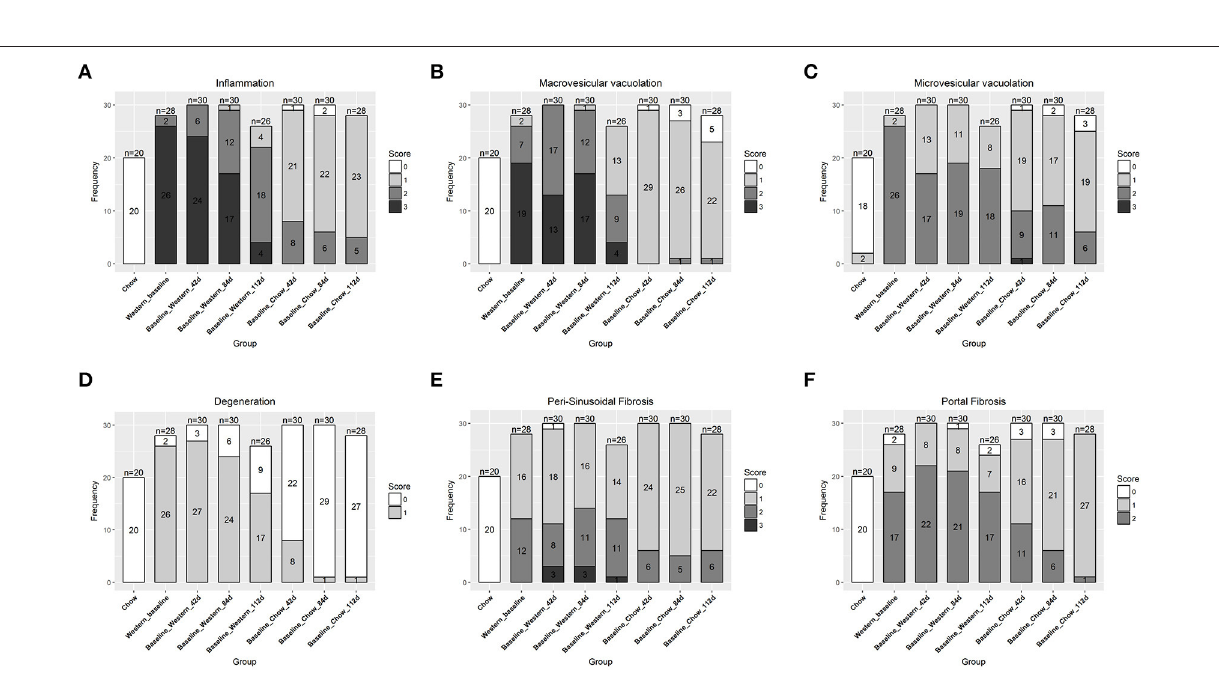
Frontiers in Pharmacology | www.frontiersin.org